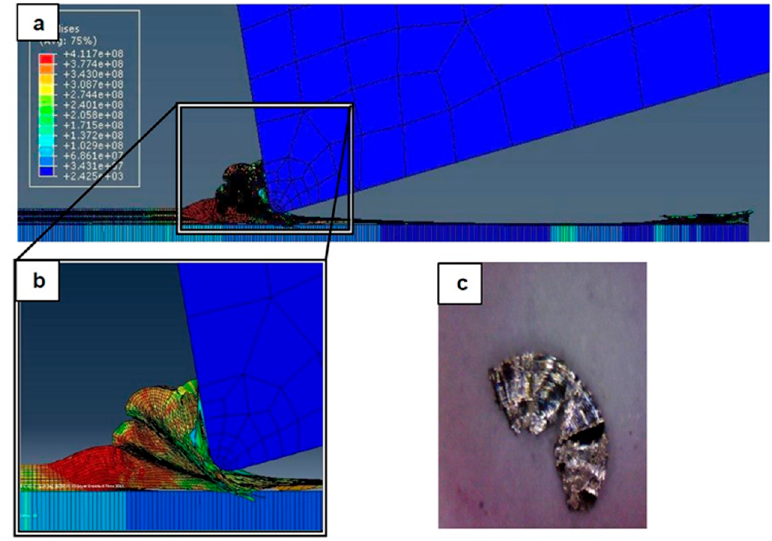
Figure 8. Machining Stainless Steel 316L at feed rate 0.02 mm / rev: ( a ) and ( b ) chip formation, and ( c ) produced chip.